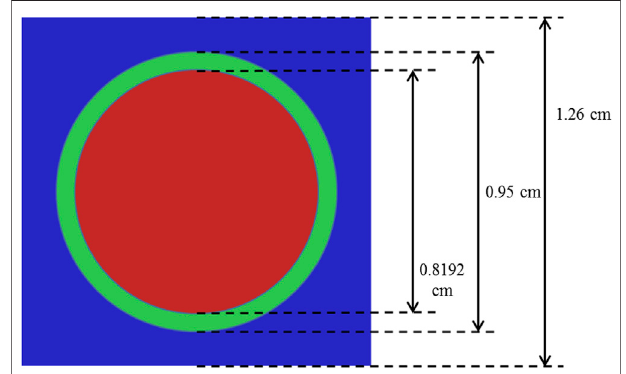
FIGURE 2 | Radial geometry for pin cell problem.